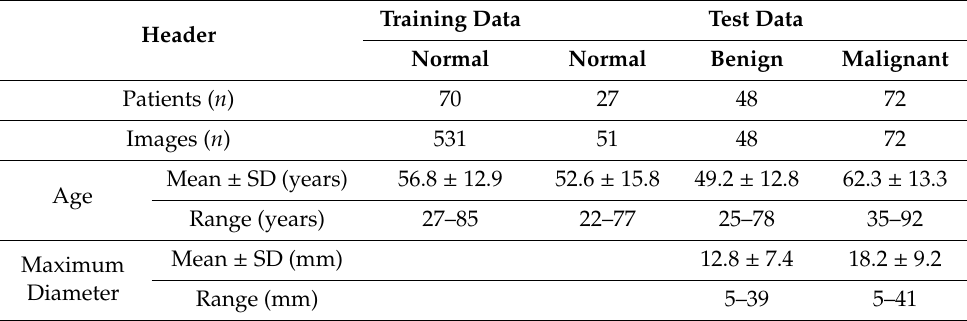
Table 1. Characteristics of patients and masses.